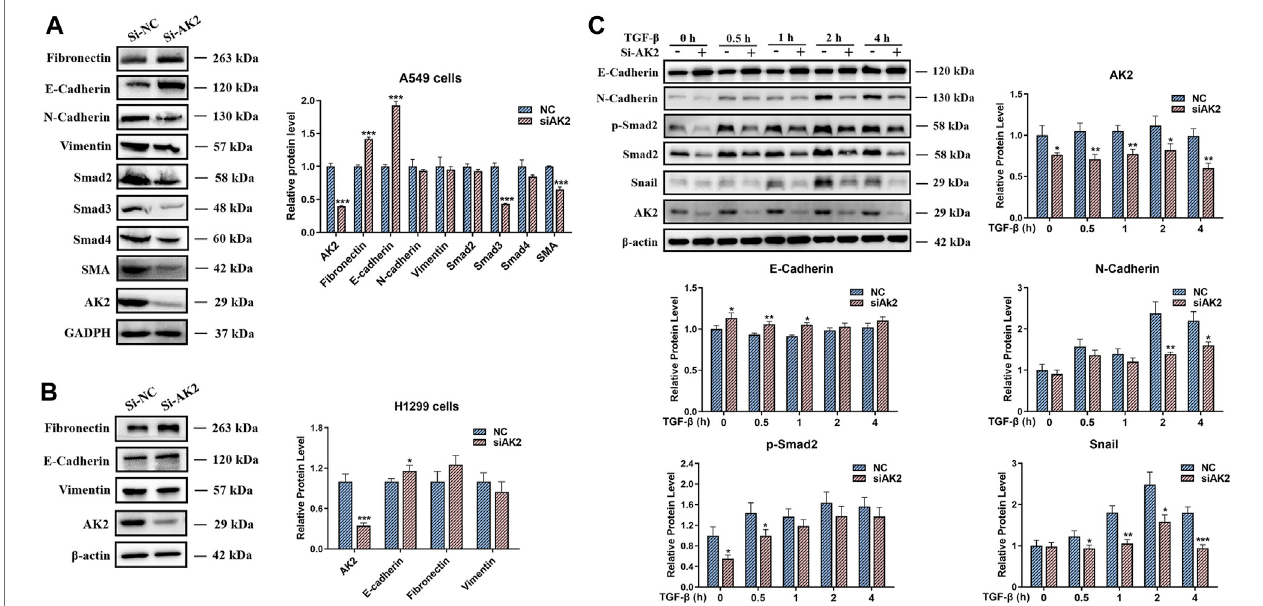
FIGURE 4| AK2 induces Snail/Smads/TGF- β signaling to activate EMT process. (A,B) A549 (A) or H1299 cells (B) were transfected with AK2 siRNA/NC for 48 h. The cell lysates were performed by western blotting analysis with indicated antibodies. (C) A549 cells were transfected with AK2 siRNA/NC for 24 h respectively, then stimulatedwith TGF- β for 0,0.5, 1, 2, 4 h, respectively. Westernblotting analysiswas performed todetect the levels ofE-cadherin, N-cadherin, p -Smad2, Smad2, Snail and AK2 respectively. β -actin was used as loading control. Band intensity was quanti fi ed by densitometry using the software Image J. Data are represented as